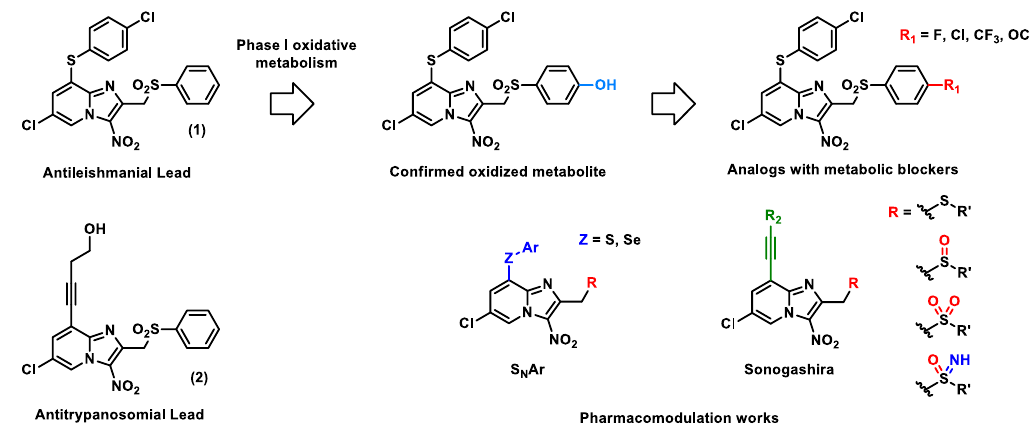
Figure 38. Lead compounds and new designed antikinetoplastid 3-nitroimidazo[1,2- a ]pyridines. 4.39. New Nitric-Oxide-Releasing Indomethacin Derivatives: Synthesis and Biological Evaluation (P39)